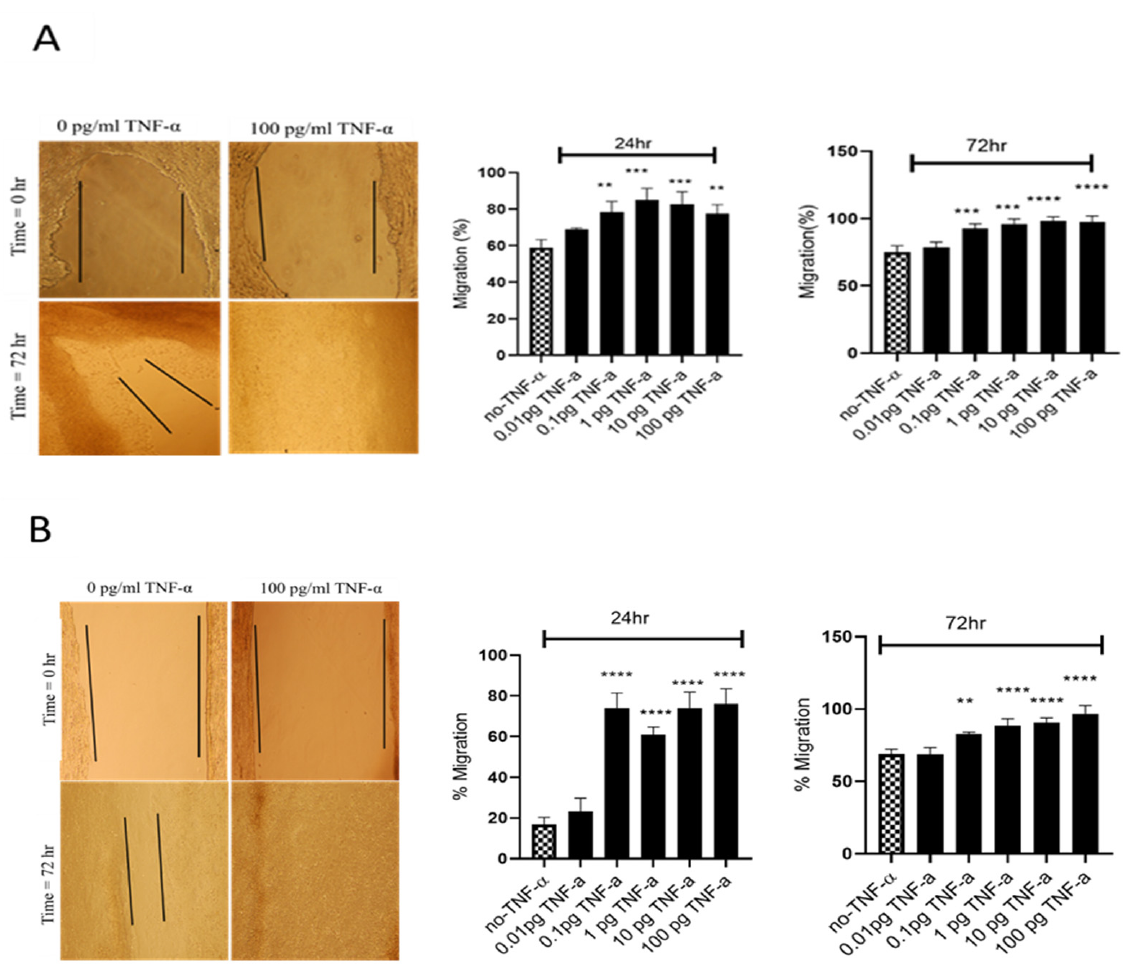
Figure 5. Effects of TNF- α on wound healing in SW480 and HCT116 cells. Wound assays were performed over 72 h using ( A ) HCT116 and ( B ) SW480 cells treated with TNF- α (0.01–100 pg/mL). Pictures of wounded cells taken at 0 and 72 h with or without TNF ‐α treatment (10× magnification). Data are expressed as % compared to vehicle control (no-TNF- α ). Significant difference was calculated using one-way ANOVA with Dunnett’s test comparing treated groups to vehicle control (GraphPad Prism 8, ** p < 0.01, *** p < 0.001, **** p < 0.0001). Error bars represent the SEM for three